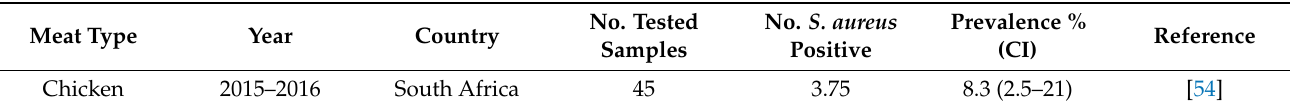
Table 4. Prevalence of S. aureus in ready-to-eat